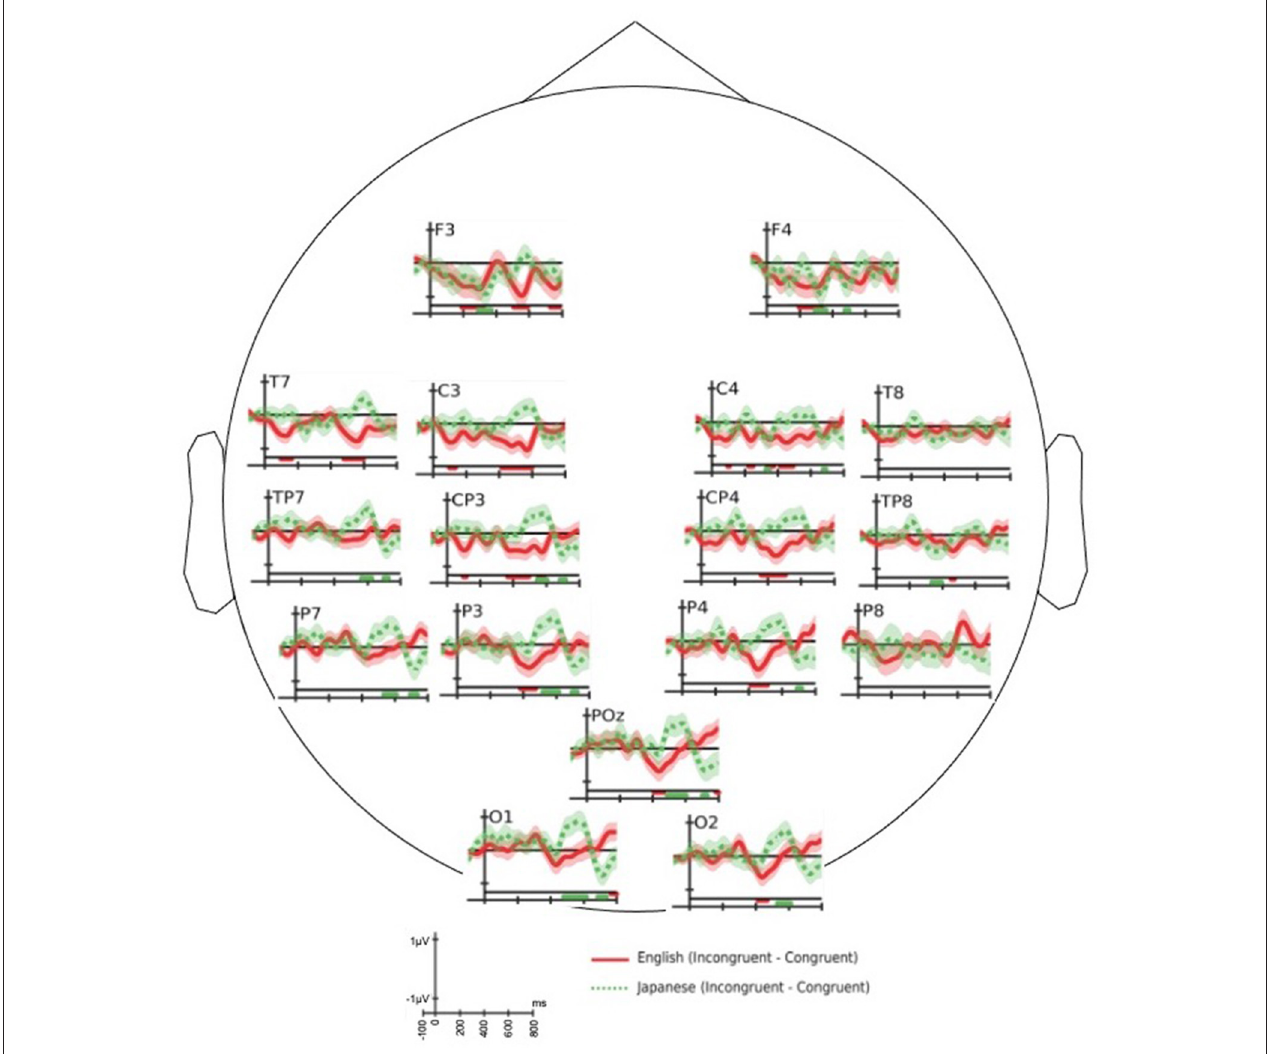
FIGURE 3 | The grand average of difference event-related potential (ERP) response of congruent end-word from in-congruent end-word: end-words in English (solid—red color) and Japanese: session 3 (dotted—green color). The horizontal bars drawn in the bottom of each plot identifies the time regions with significant (two-sample t -test with p < 0.05) difference in the ERP response. The bars have the same color of the associated difference